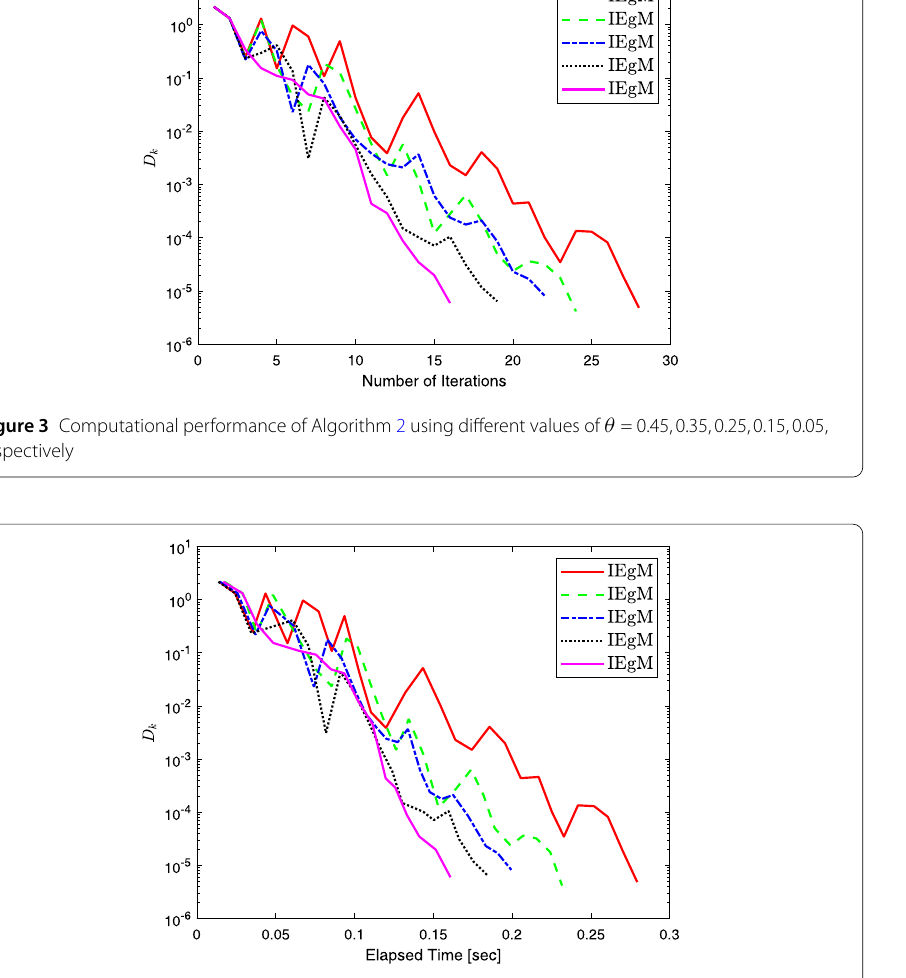
Experiment 3: In the third experiment, we consider Example 4.1 to see the computational performance of Algorithm 2 with Algorithm 3.1 in [36] using different choices for the dimension M . Two P , Q matrices are taken randomly [Two diagonal matrices randomly A 1 and A 2 with elements from [0,2] and [–2,0], respectively. Two random orthogonal matrices O 1 = RandOrthMat ( M ) and O 2 = RandOrthMat ( M ) are generated. Thus, a